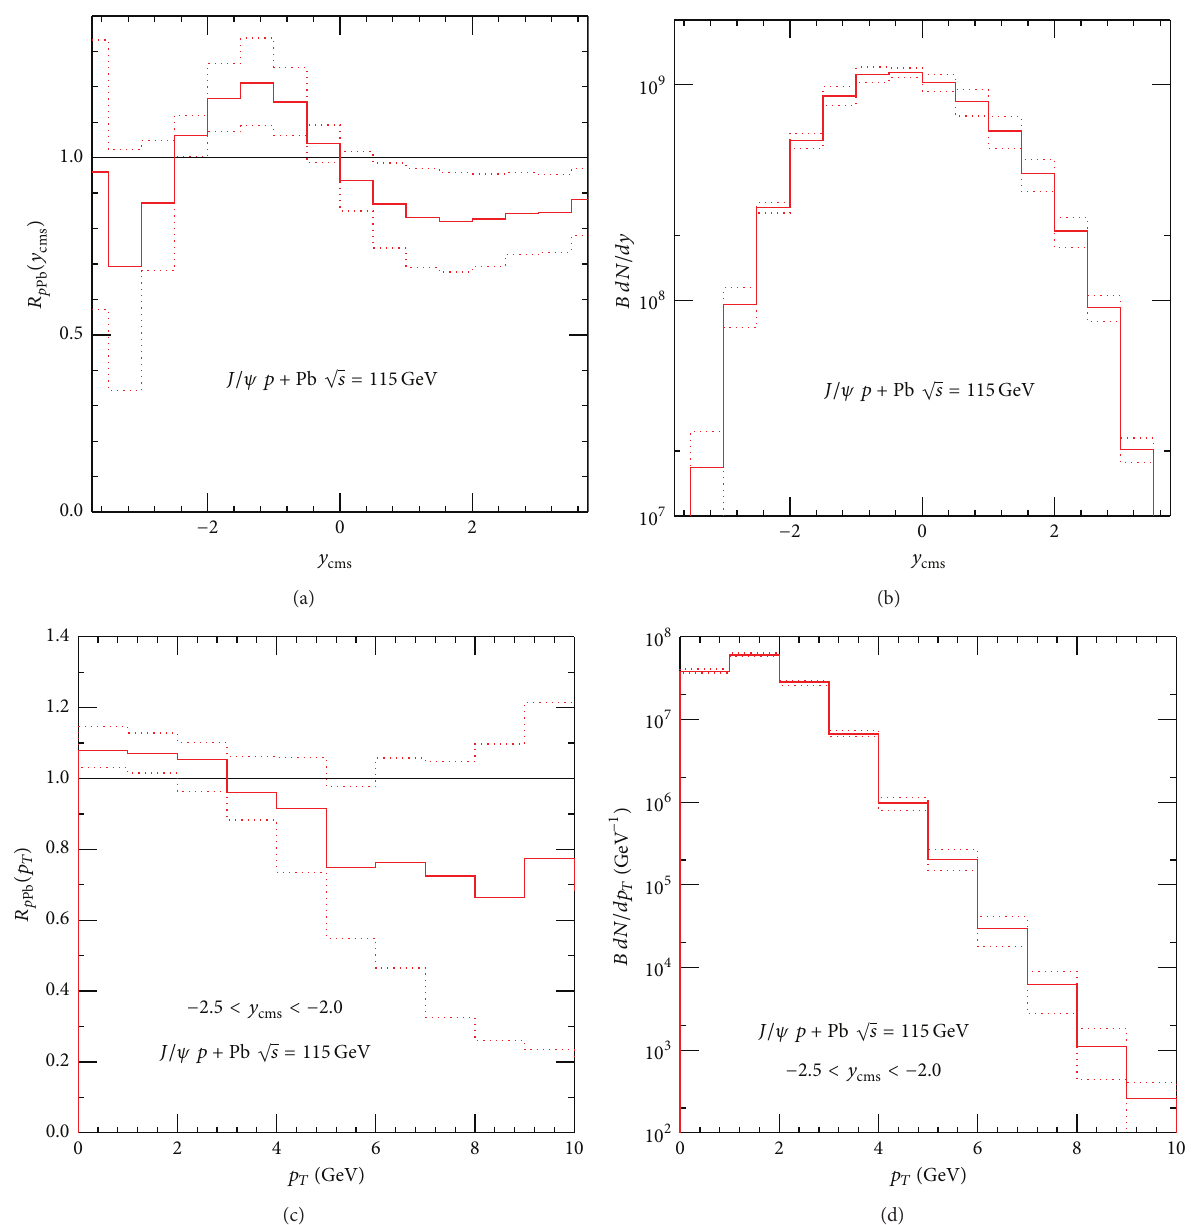
Figure 2: The predicted 𝐽/𝜓 shadowing ratios (a, c) and rates (b, d) as a function of center of mass rapidity (a, b) and 𝑝 𝑇 (c, d) for 𝑝 + Pb collisions at √𝑠 𝑁𝑁 = 115 GeV. The solid curve in each plot is the central EPS09 NLO result, while the dotted curves outline the shadowing uncertainty